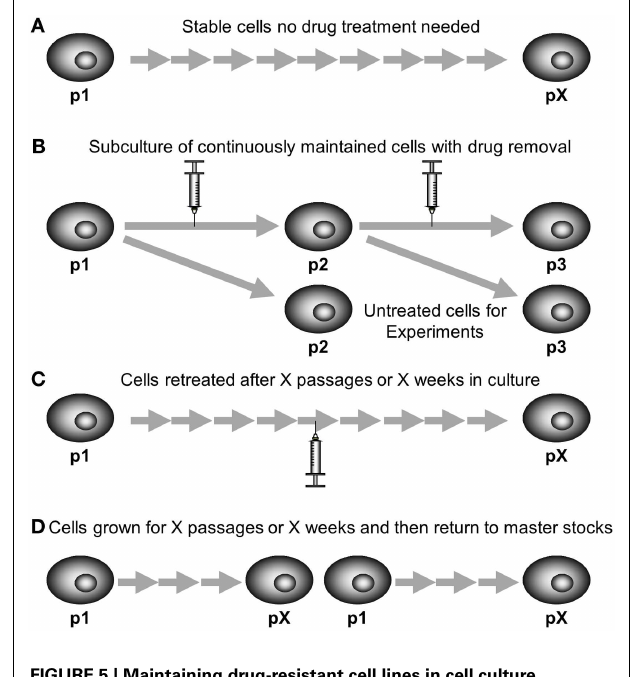
FIGURE 5 | Maintaining drug-resistant cell lines in cell culture . (A) Stable cell lines require no drug treatment to maintain their resistant phenotype. (B) Some cell lines are grown continually in the presence of chemotherapy, chemotherapy needs to be removed for one subculture prior to using for experiments. (C) Some models are repeat pulse treated after a certain number of passages or weeks in culture once their resistant phenotype begins to fade. (D) Some models are discarded and new cells grown from master stocks after a certain number of passages or weeks in culture once their resistant phenotype begins to